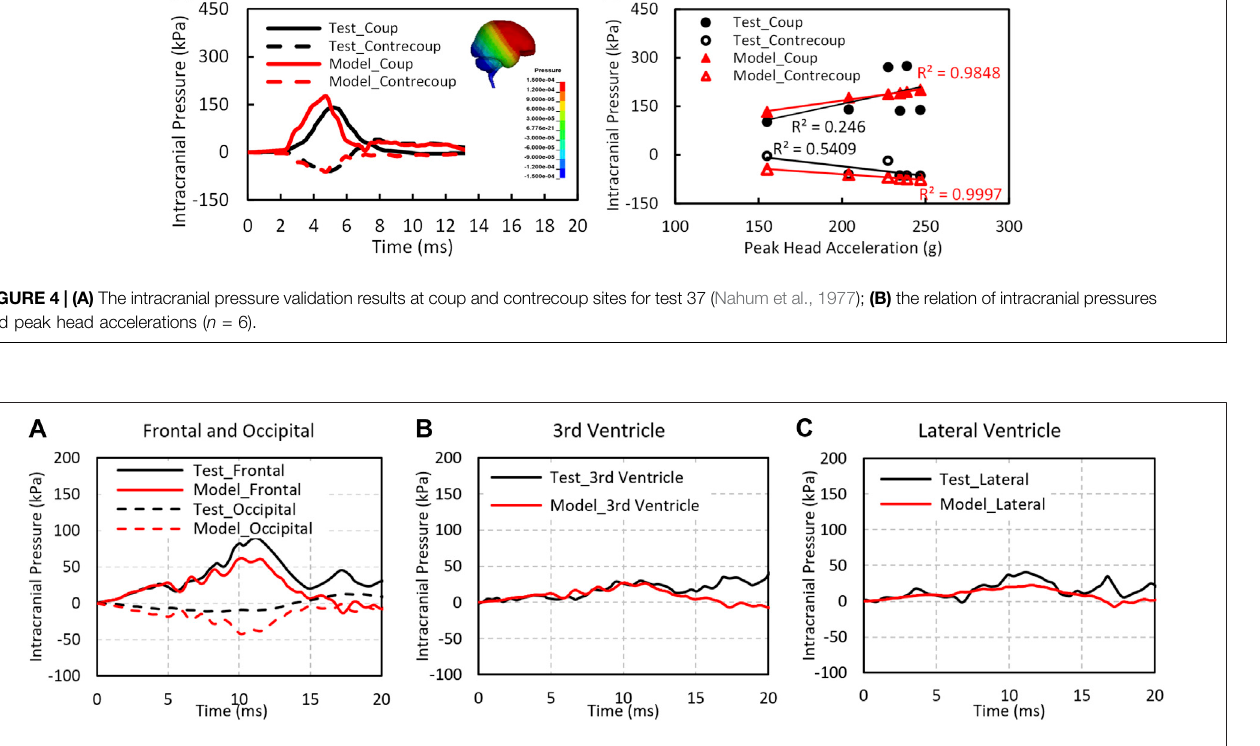
Figure 6 . The shape of the model predicted facial F-D response to impact showed a concave shape that was consistent with the experimental response. In the test curves, two slopes were observed. The fi rst 4-mm slope denotes the compression of